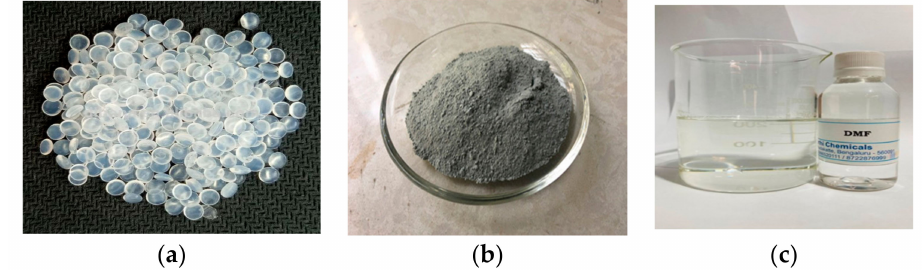
Figure 1. Material in membrane fabrication: ( a ) PVDF, ( b ) tin dioxide, and ( c )